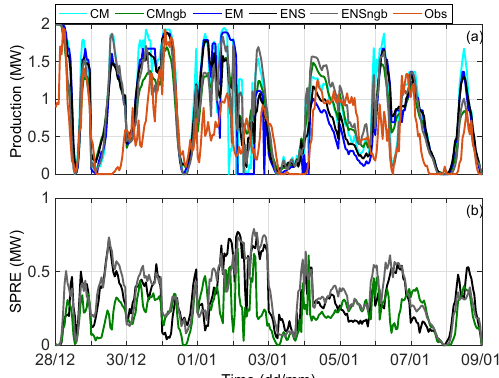
Figure 11. Site B. (a) ENS mean MVD for the solid water compo- nents. (b) Mean spread of MVD for the solid water components.